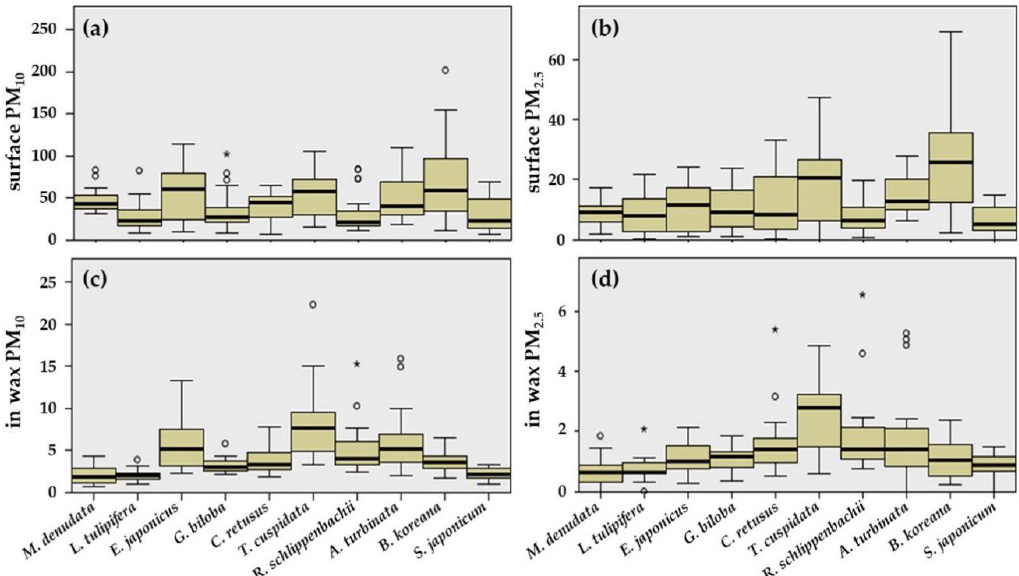
Figure 3. Box-plot of the Kruskal–Wallis rank-sum test for PM particle amounts (mg / m 2 ) on surface PM 10 , surface PM 2.5 , wax PM 10 , and wax PM 2.5 from leaves of ten plant species growing in the Seoul Forest Park: ( a ) Surface PM 10 ; ( b ) surface PM 2.5 ; ( c ) in wax PM 10 ; and ( d ) in wax PM 2.5 . Note: Group differences in PM deposition data were tested using the non-parametric Kruskal–Wallis analysis ( n = 20 each group).